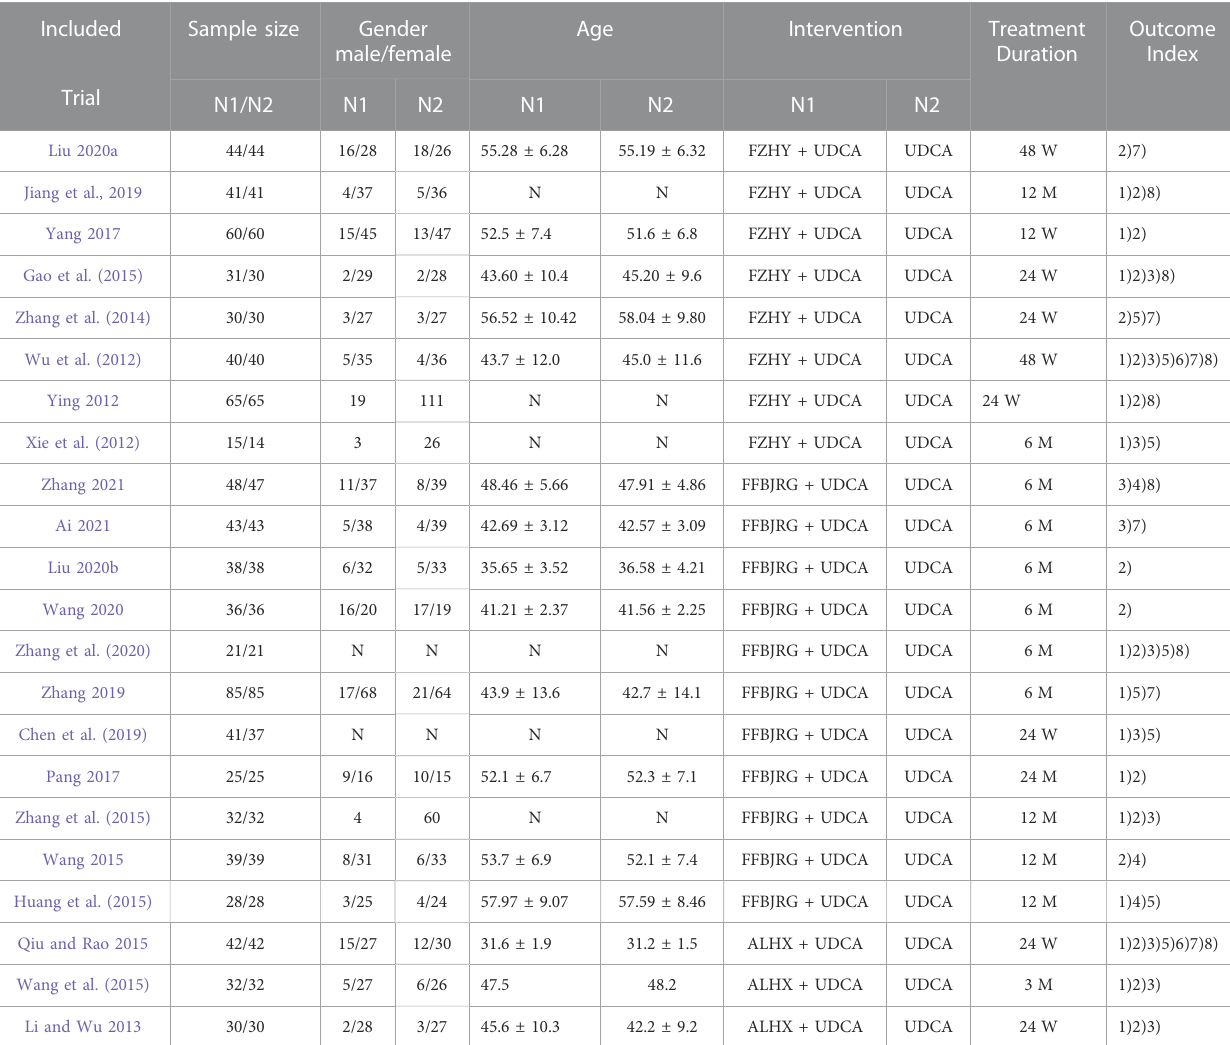
TABLE 2 Basic characteristics of the included studies. Included